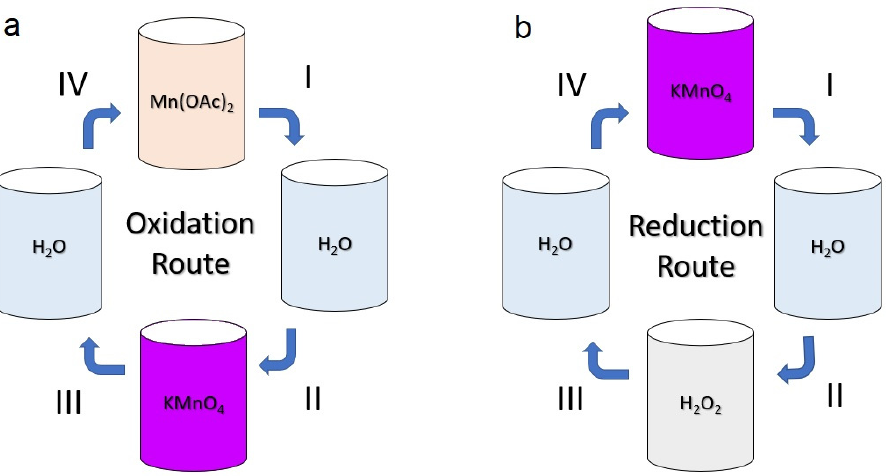
Figure 1. Scheme of oxidation ( a ) and reduction ( b ) route of manganese oxide via the SILD